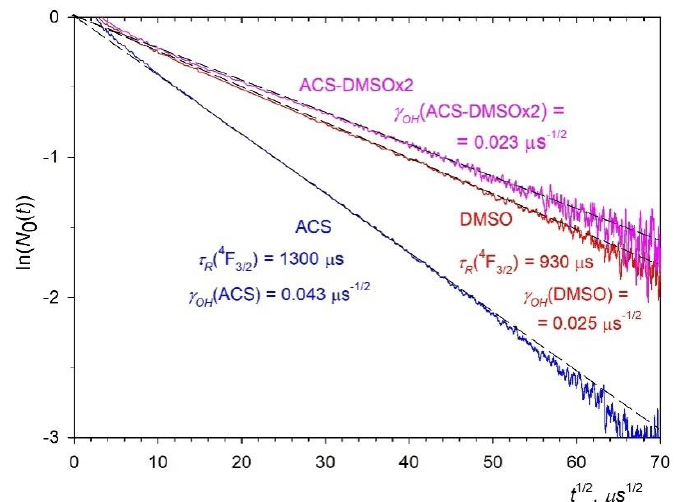
Figure 8. Kinetics of static fluorescence quenching of the 4 F 3/2 level of the Nd 3+ ion of the 0.1 at. % Nd 3+ : LaF 3 NPs colloids in special coordinates: ACS — blue curve, DMSO — red curve, and ACS-DMSOx2 — magenta curve; dashed thin black lines show the slope of the impurity fluorescence quenching kinetics, which is used to determine the energy transfer macroparameter γ OH